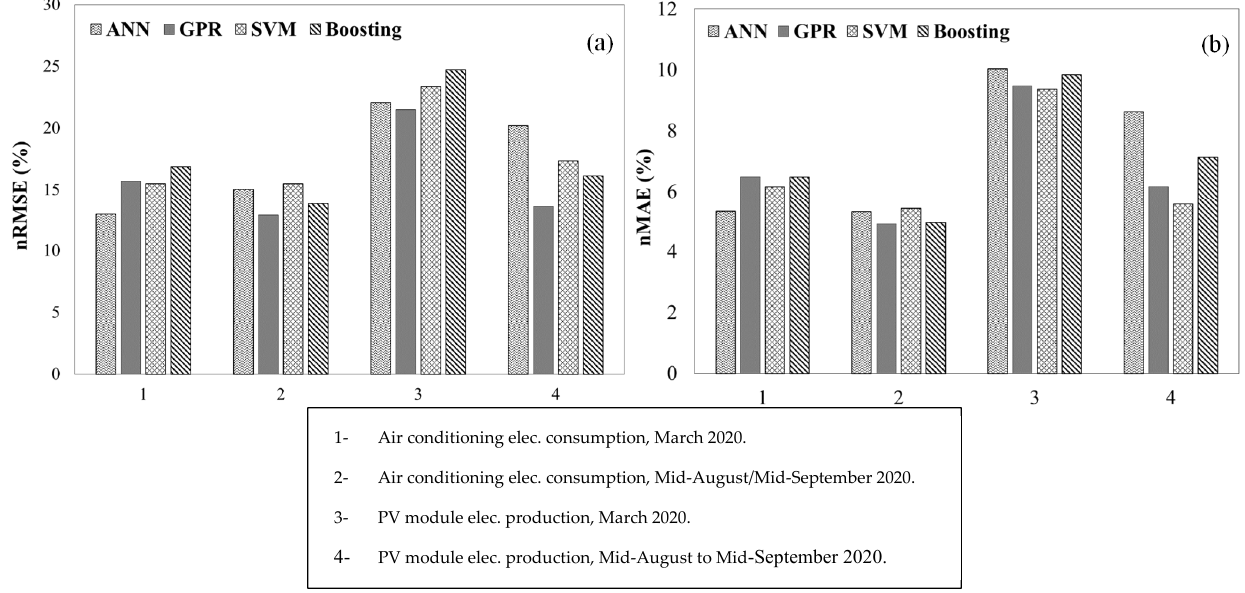
Figure 10. The models’ performances: ( a ) normalized root mean square error ( nRMSE ) and ( b ) normalized mean absolute error ( nMAE ).